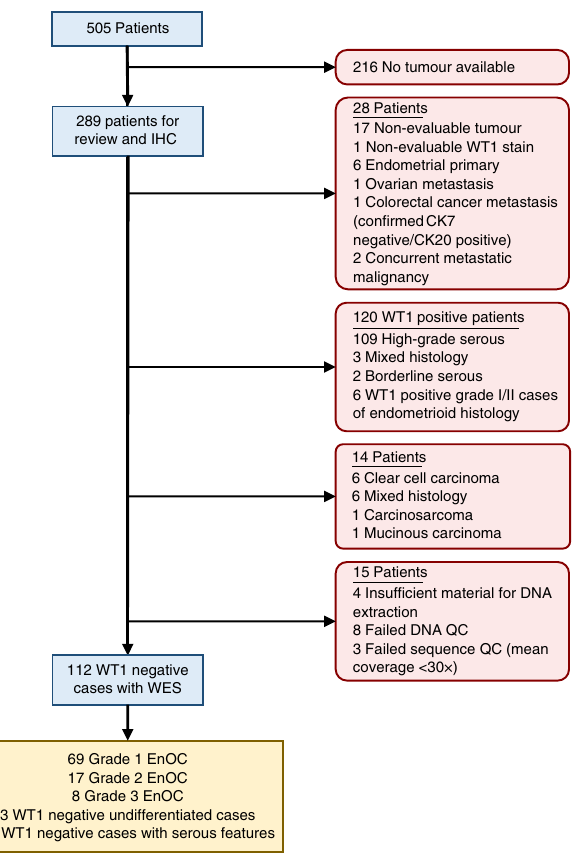
Fig. 1 Flow diagram identifying endometrioid ovarian carcinoma cases for whole exome sequencing. IHC immunohistochemistry, WES whole exome sequencing, EnOC endometrioid ovarian carcinoma, WT1 Wilms ’ tumour 1, QC quality